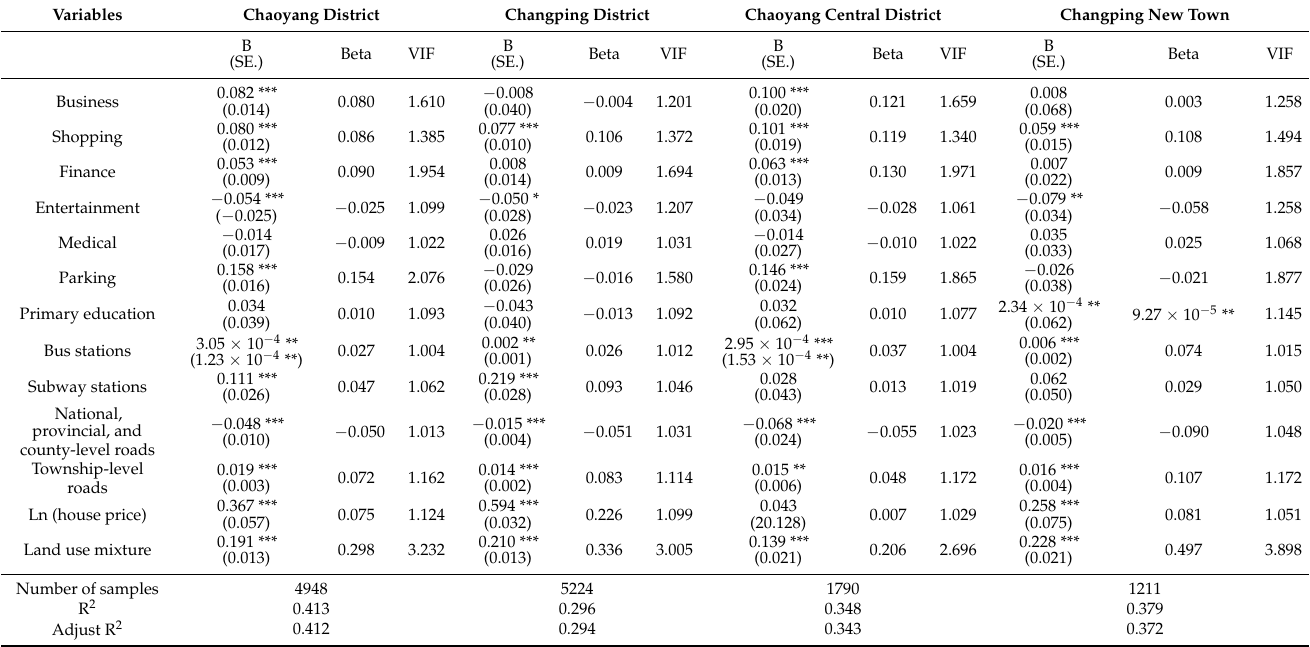
Table 5. Regression results of status quo FAR